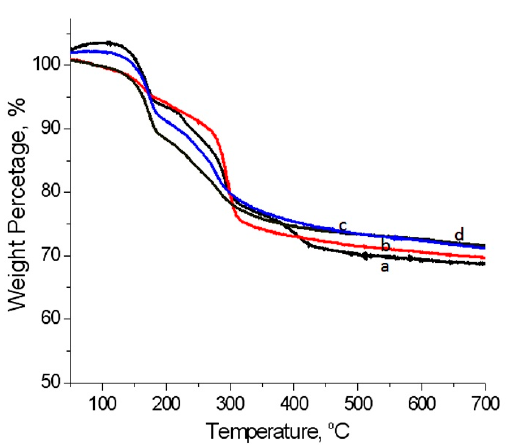
Figure 6. TGA curves of: ( a ) Zn-Al LDH, ( b ) Zn-Al-GO1, ( c ) Zn-Al-GO2, and ( d ) Zn-Al-GO3.